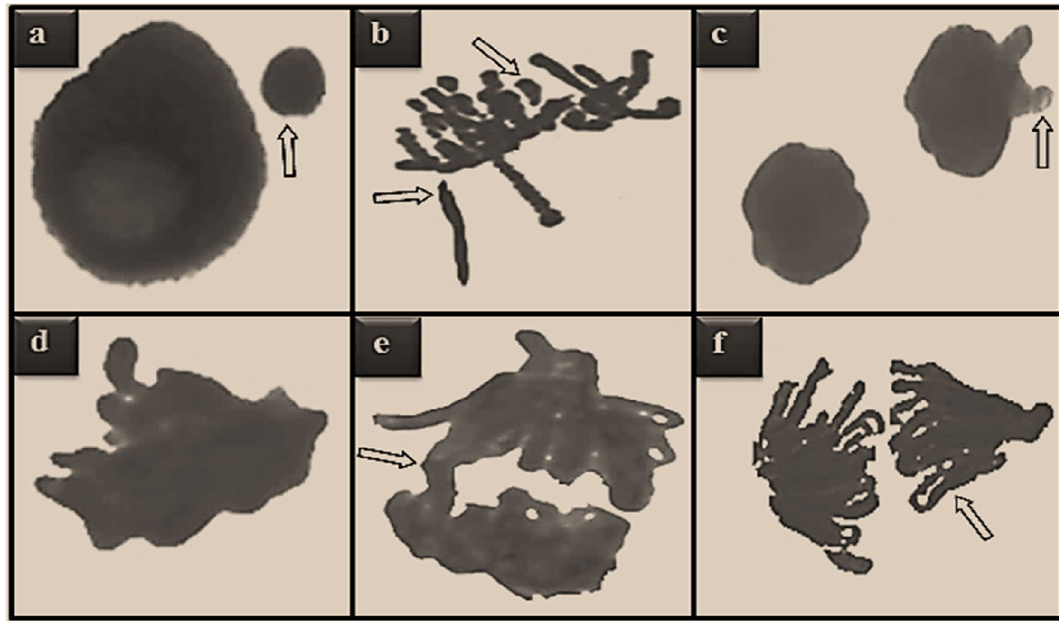
Figure 3. CAs induced by uranyl acetate. MN in interphase ( a ), fragment in metaphase ( b ), vagrant chromosome in anaphase ( c ), sticky chromosome in prophase ( d ), bridge in early anaphase ( e ), unequal distribution of chromatin in anaphase ( f